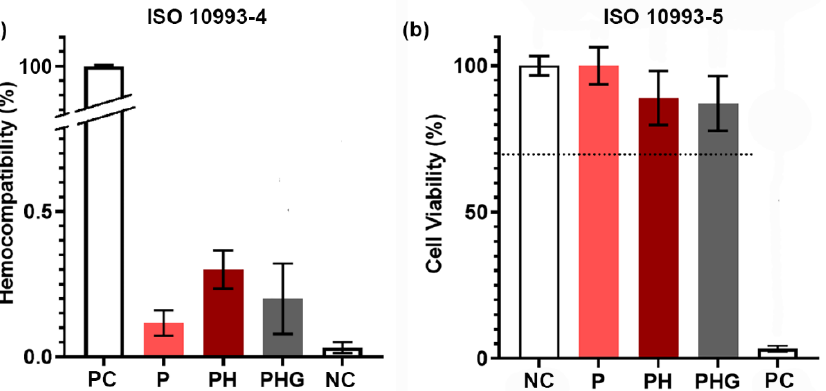
Figure 5. ( a ) In vitro hemocompatibility, and ( b ) indirect in vitro cytotoxicity of P, PH, PHG mem- branes (NC: negative control; PC: positive control). The dashed line at 70% in b indicates the lower limit of in vitro cytocompatibility.